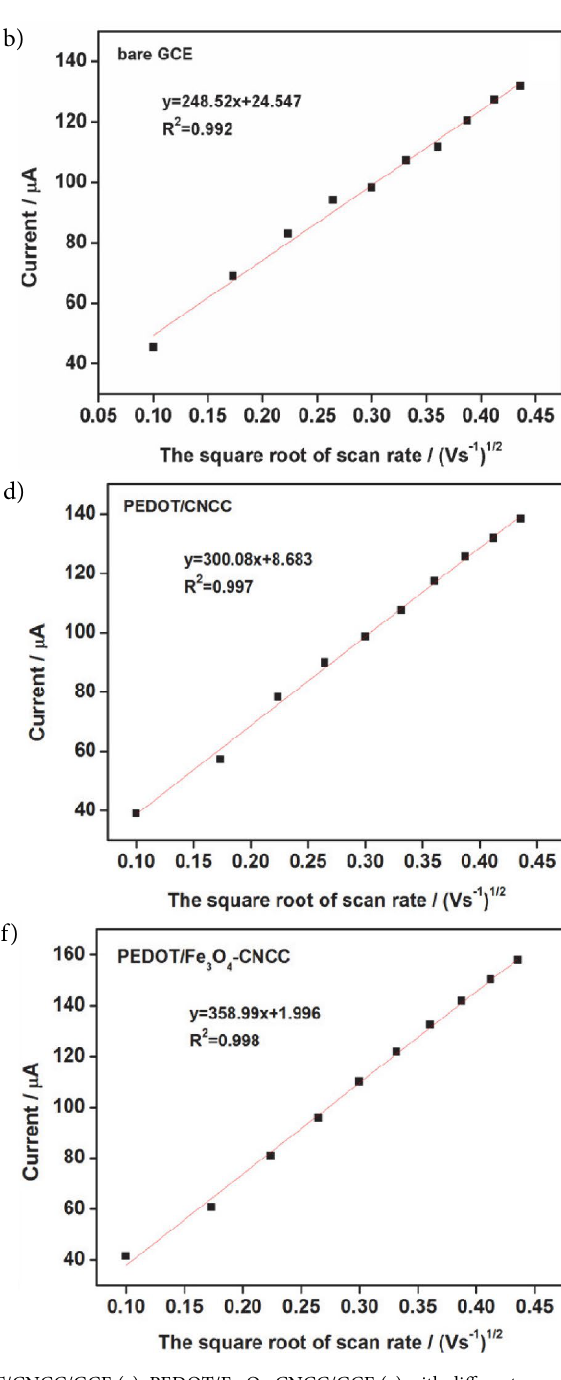
Fig 4. Cyclic voltammograms of 5 mM Fe(CN) 63–/4– at bare GCE (a), PEDOT/CNCC/GCE (c), PEDOT/Fe 3 O 4 -CNCC/GCE (e) with different scan rate, and (b), (d), (f) the corresponding plots of current at a, c, e versus the square root of the scan rate,